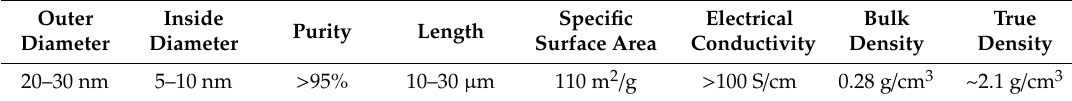
Table 1. Specifications of multiwalled carbon nanotubes (MWCNTs) used in the present research. Outer